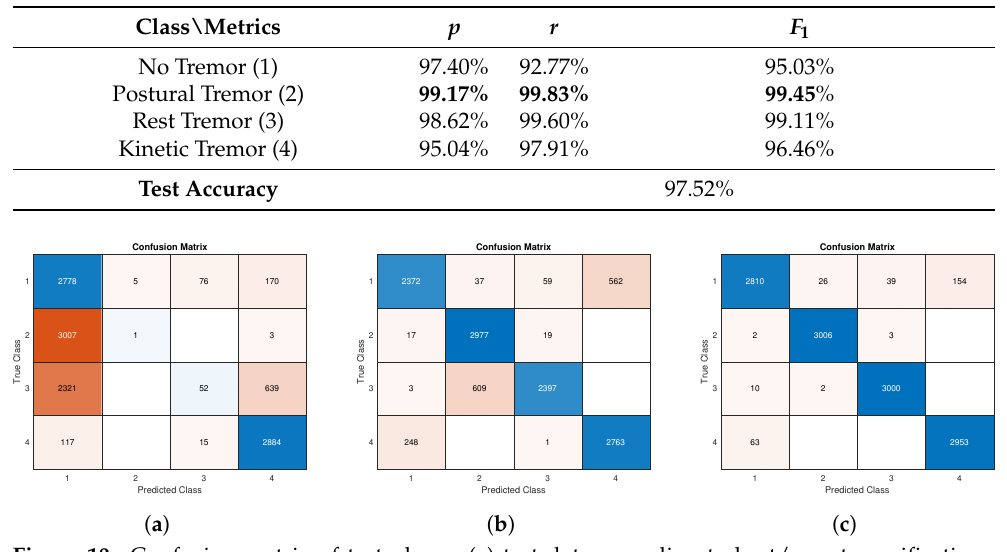
Figure 10. Confusion matrix of test phase: ( a ) test data according to best/worst specifications; ( b ) test data according to worst/best specifications; ( c ) test data according to worst/worst